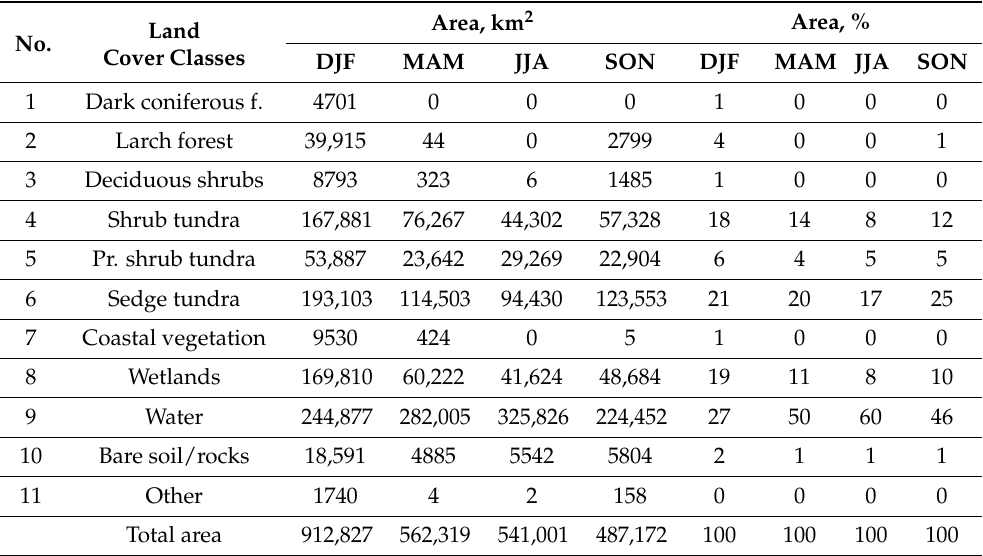
Table 1. Land cover classes in the footprint throughout the seasons based on Terra Norte RLC 2014 vegetation map